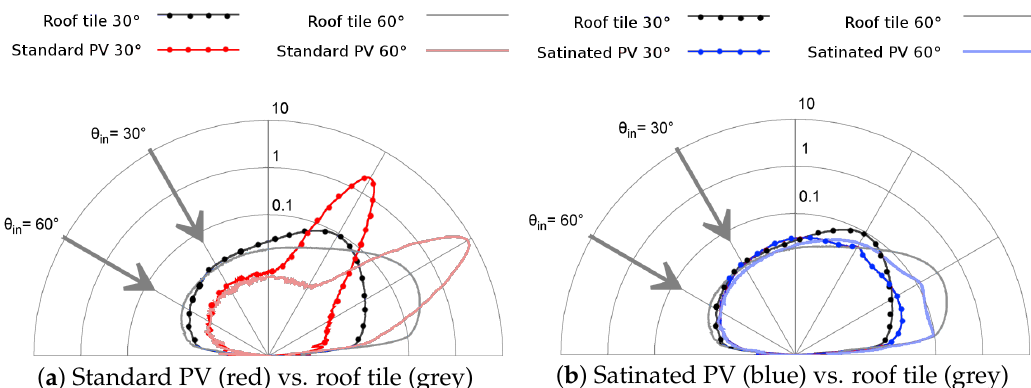
Figure 7. Photographs of material samples used in the case study: standard PV ( a ), satinated PV ( b ), and existing roof tile ( c ).